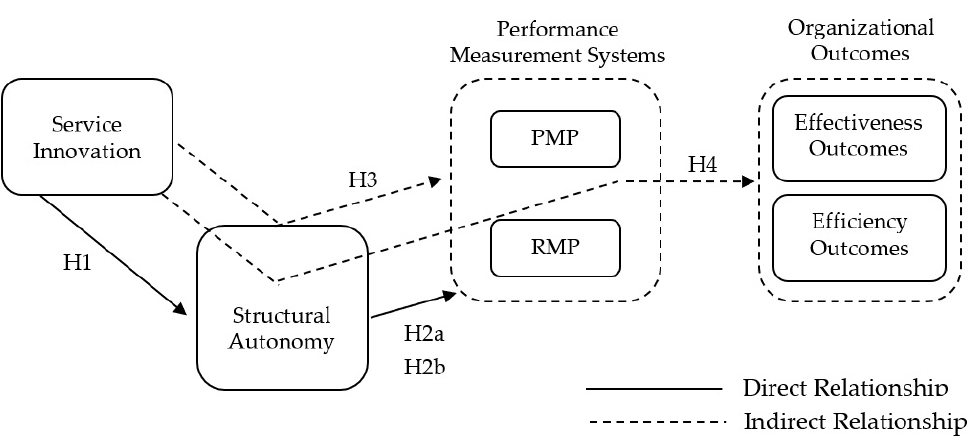
Figure 1. Hypothesized Model.